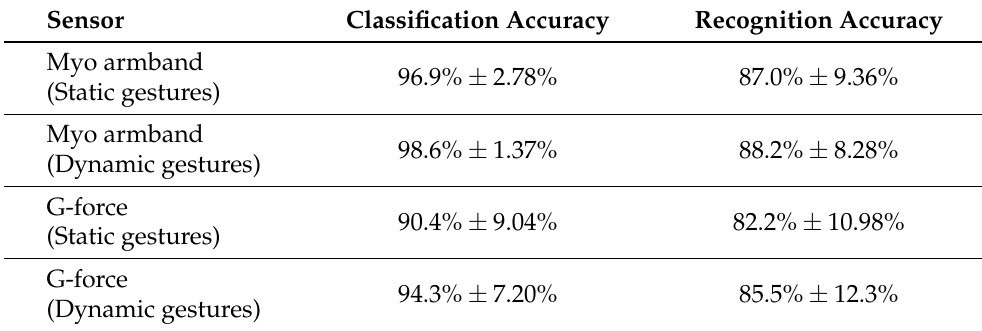
Figure 5. User-specific HGR model classification and recognition accuracy results for the G-force sensor using DQN. ( a ) Static gestures. ( b ) Dynamic gestures. Table 3. User-specific validation: best results for Myo armband and G-force